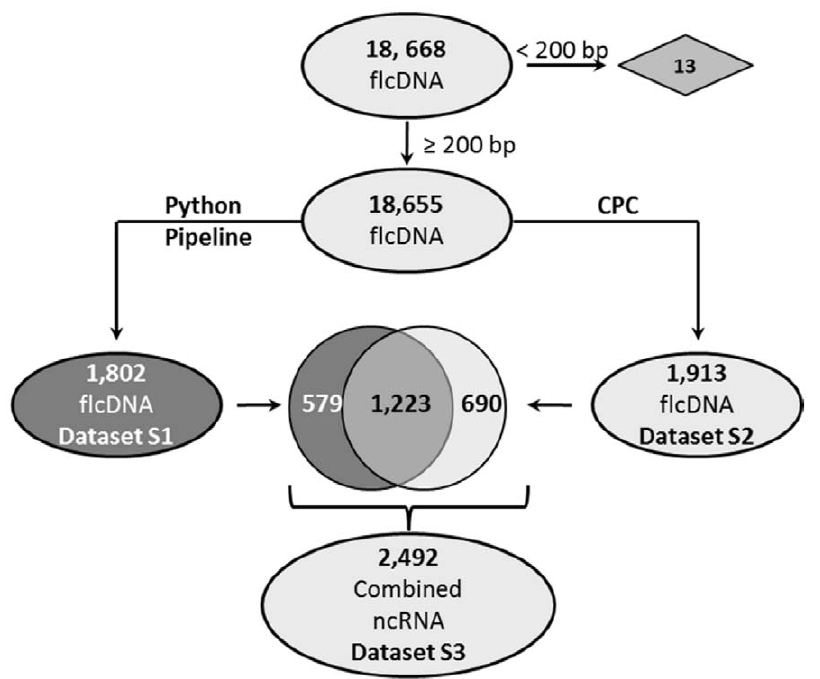
Figure 2. Combination of the Python Pipeline and CPC results. The Python Pipeline and CPC were used to identify noncoding RNAs, the number of transcripts identified as noncoding by each method is indicated. A subset were classified as noncoding by both methods, others were identified exclusively by one set or the other. The sequences identified as noncoding by either method were combined into one comprehensive set (Combined ncRNA). Datasets for ncRNAs identified by the Python pipeline, CPC, and the combined set were designated Dataset S1, S2, and S3 respectively (supplementary data).